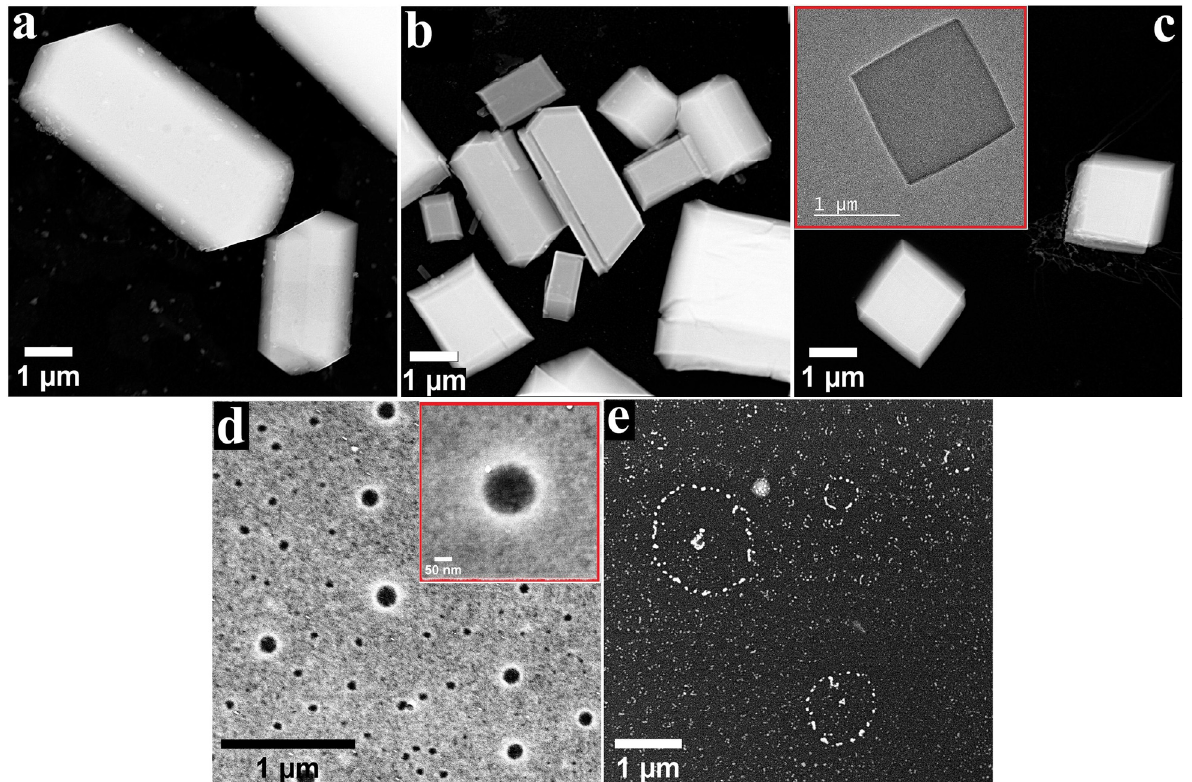
Figure 1. STEM images recorded for ZnP drop ‐ casted on TEM grids from solutions obtained using the following solvents: ( a ) DMSO, ( b ) DMF, ( c ) PhCN, ( d ) THF, and ( e ) DCM. The inset in ( c ) shows the TEM image of a ZnP aggregate, and the inset in ( d ) presents a STEM image recorded at a higher